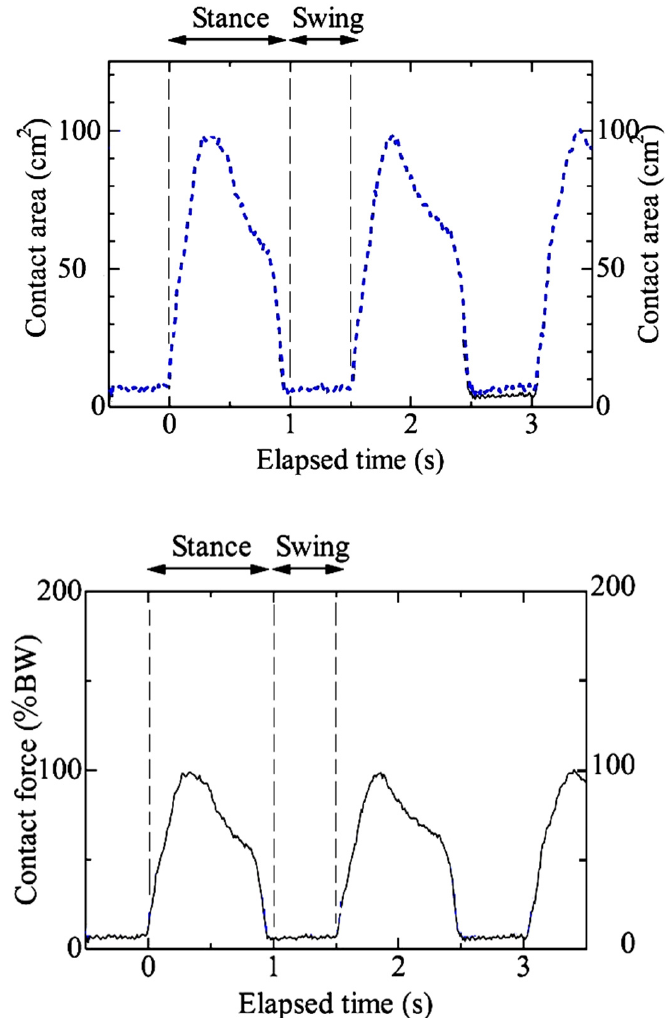
Figure 3. Shoe contact area and contact force for V = 3.0 km/h modified from [2].